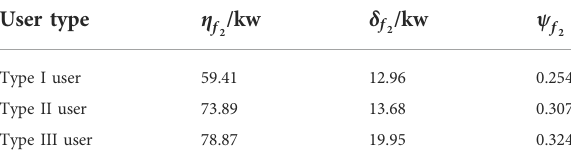
TABLE 5 Average values of different type IDR potential users in peak period